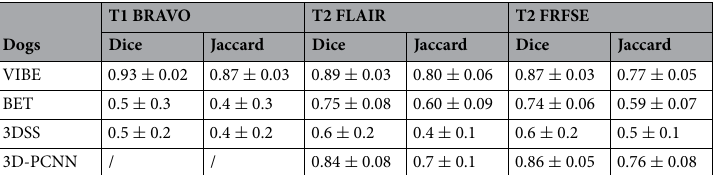
Table 3. Dogs cohort results. Comparison of the mean and standard deviation results of both the Dice similarity coefficient and Jaccard index for three different MRI contrasts (T1 BRAVO, T2 FLAIR and T2 FRFSE) and different algorithms (VIBE, BET, 3DDS and 3D-PCNN).